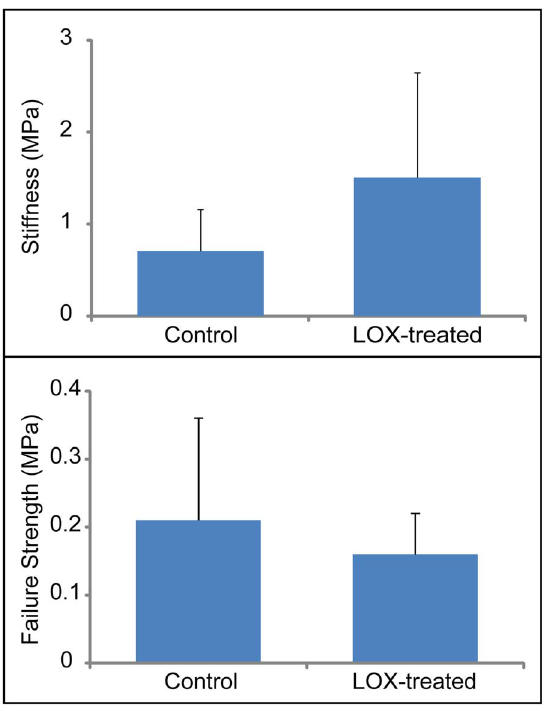
Figure 5. Tensile mechanical data of explant/explant interface. No differences in apparent stiffness (top) or apparent strength (bottom) were seen when LOX was applied to native-to-native integration.